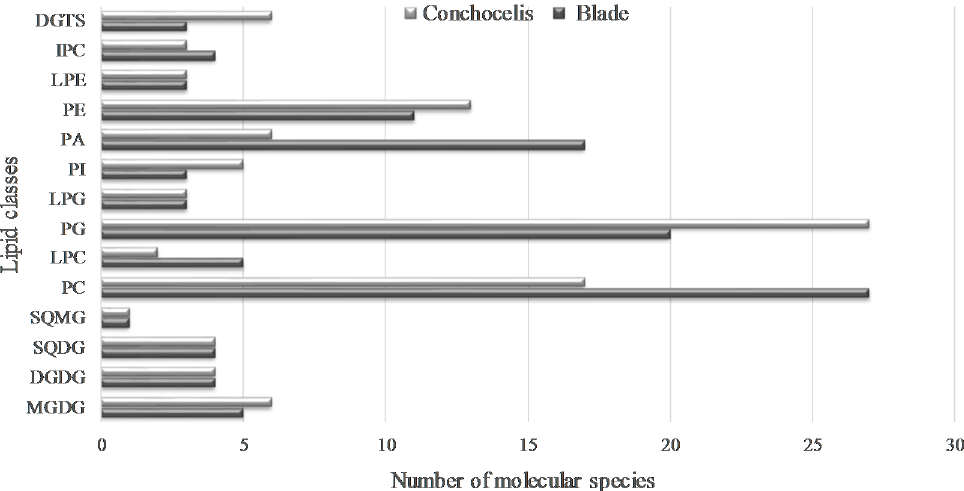
Figure 5 . Number of individual lipids identified in the lipidome of blades and conchocelis of Porphyra